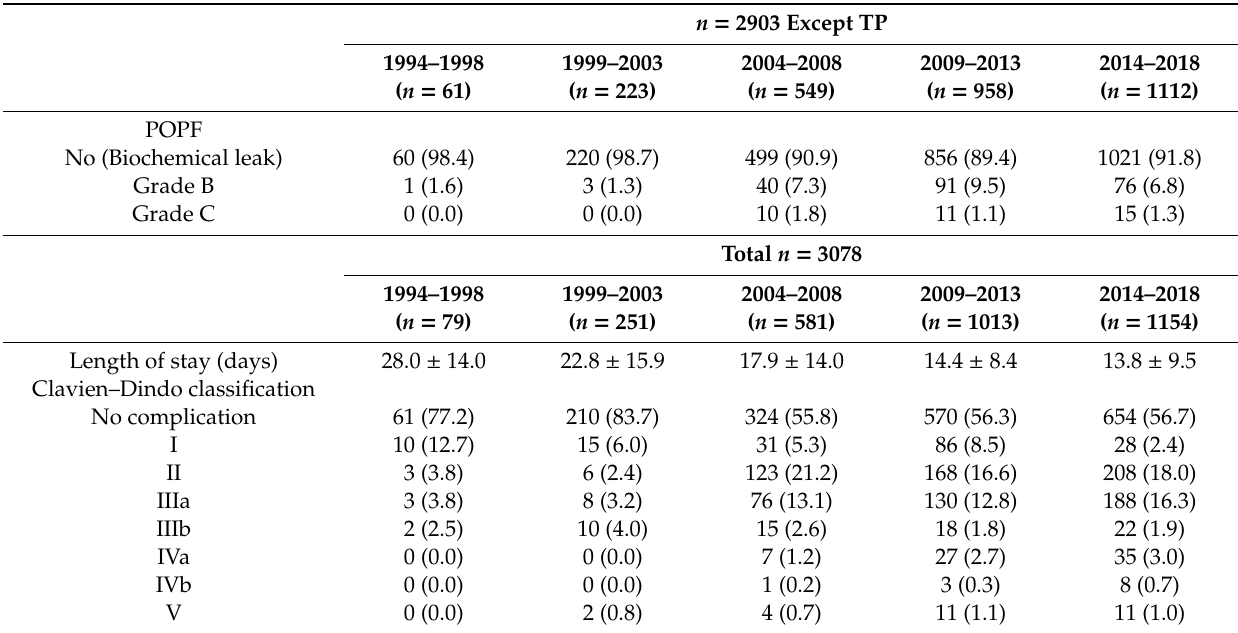
Table 4. Chronologic changes of postoperative features of all patients (Mean ± Standard deviation and number